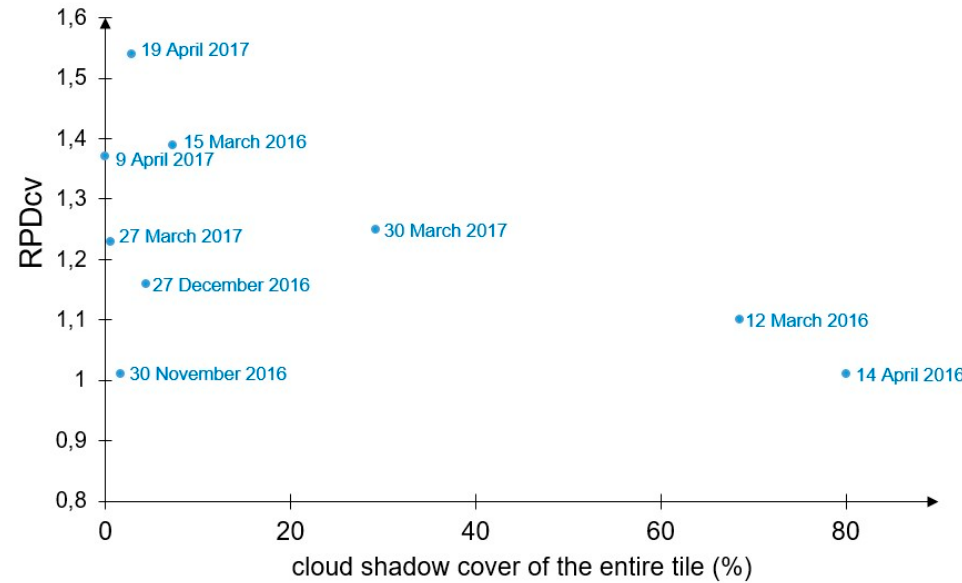
Figure 2. Plot of cross-validation residual prediction deviation (RPDcv) against the cloud and cloud shadow cover of the entire tile.